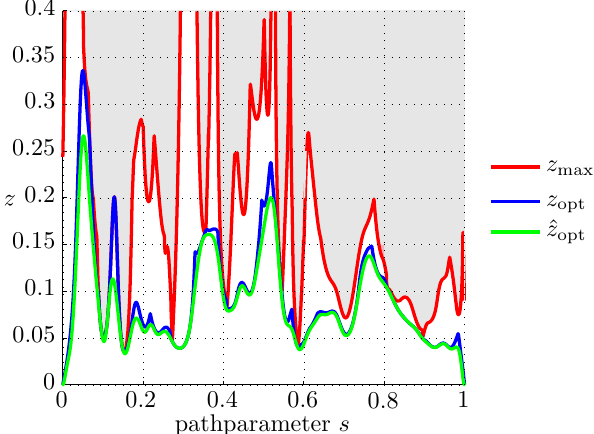
Figure 9. Motor torques, above: torque trends for the SDP solution, below: torque trends for the smooth solution.